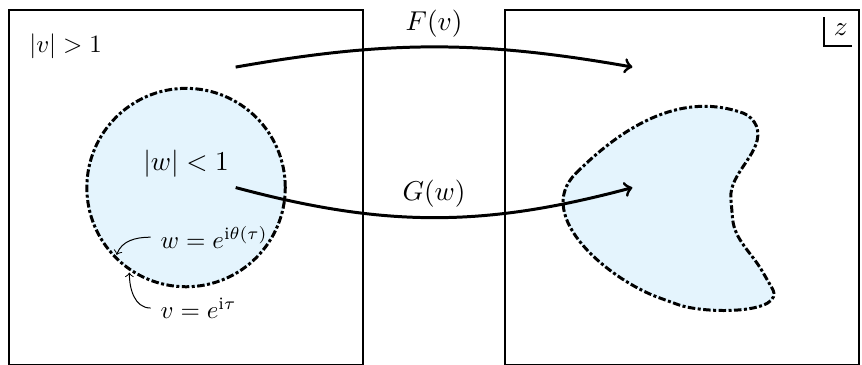
Figure 1. In the conformal welding problem two regions parametrized by | w | ≤ 1 and | v | ≥ 1 are glued together along their boundaries, by finding holomorphic functions: G ( w ) , F ( v ) subject to the boundary condition (2.22). In the JT gravity on an AdS 2 black hole coupled to a flat bath region, we parametrize the former by w and the latter by v